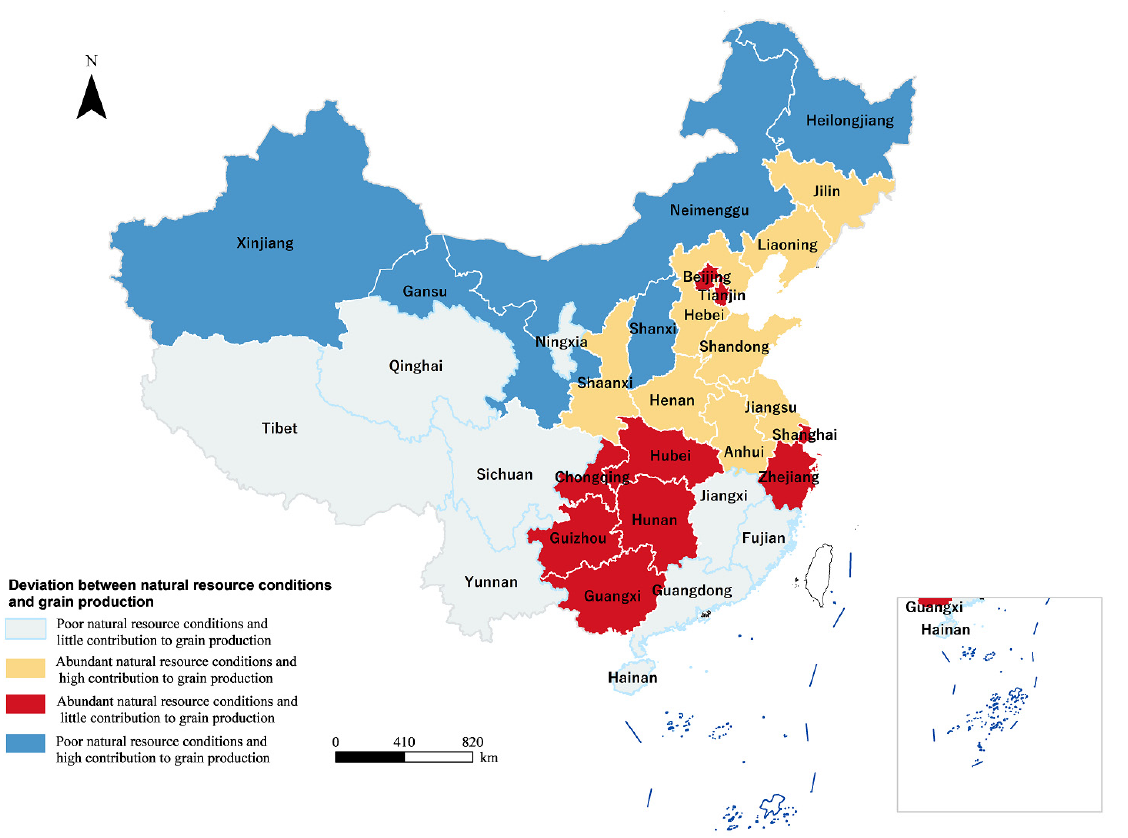
Figure 4. The deviation of China’s grain production pattern and natural conditions pattern.